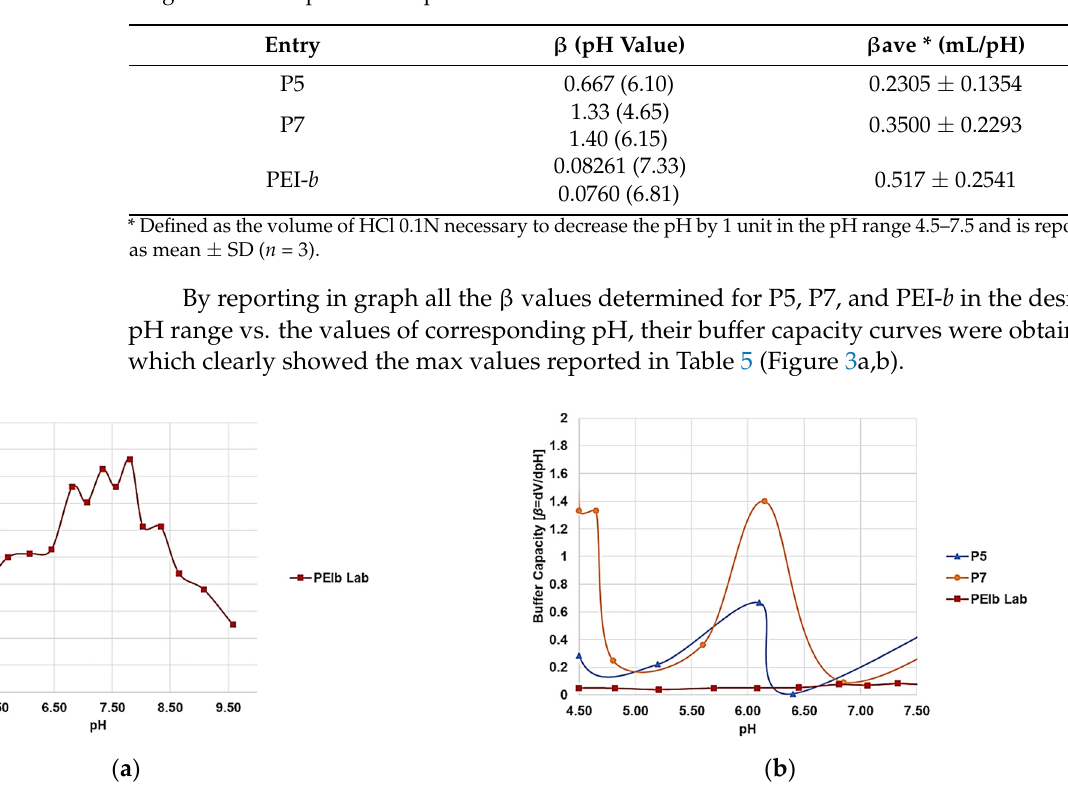
Table 5. Max β values and β ave of P5, P7, and commercial polyethyleneimine (PEI- b ) in the pH range 4.5 – 7.5 computed from potentiometric titrations data.